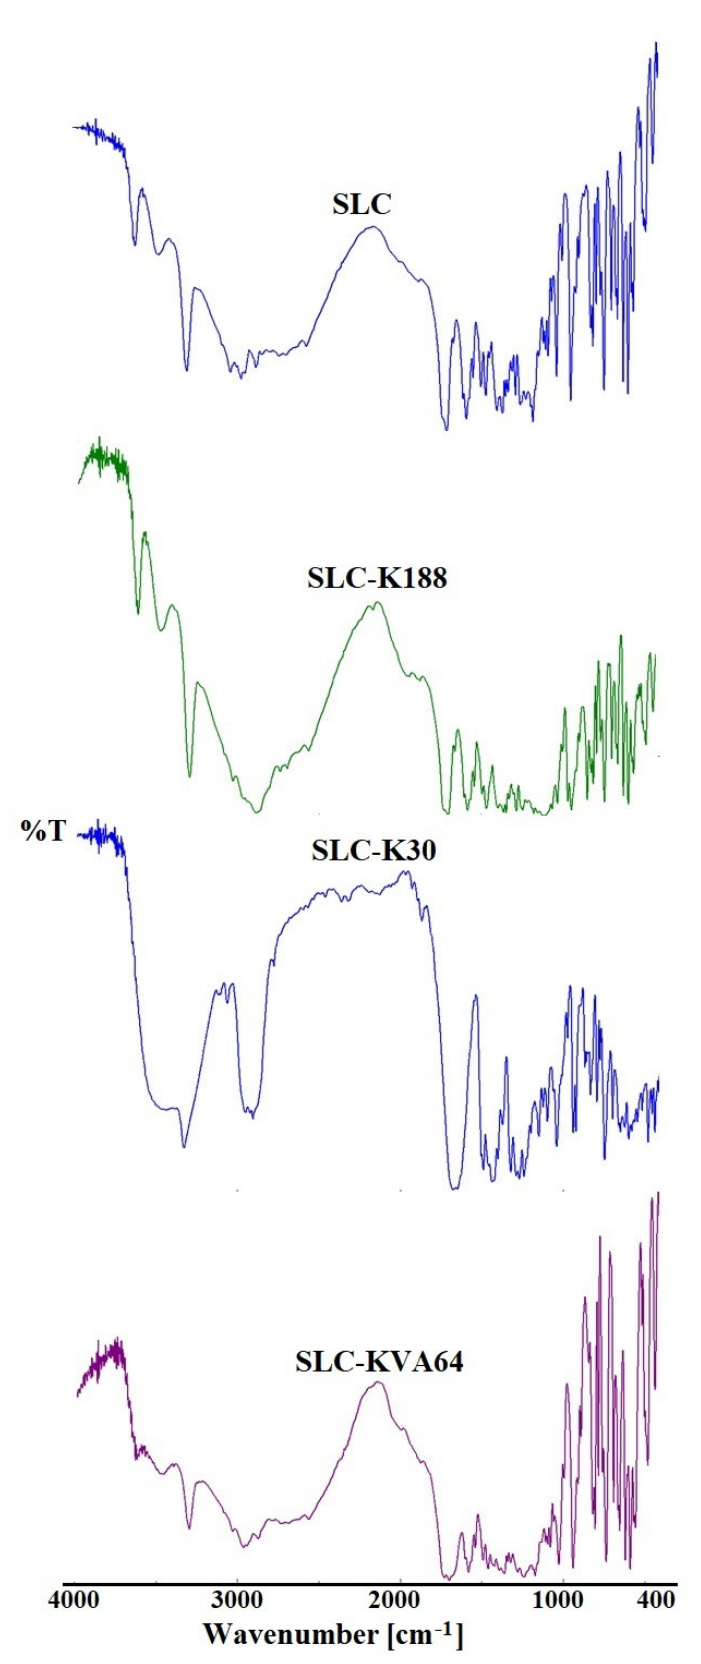
Figure 3. Comparative FTIR spectra of pure SLC, SLC-K188, SLC-K30, and SLC-KVA64.